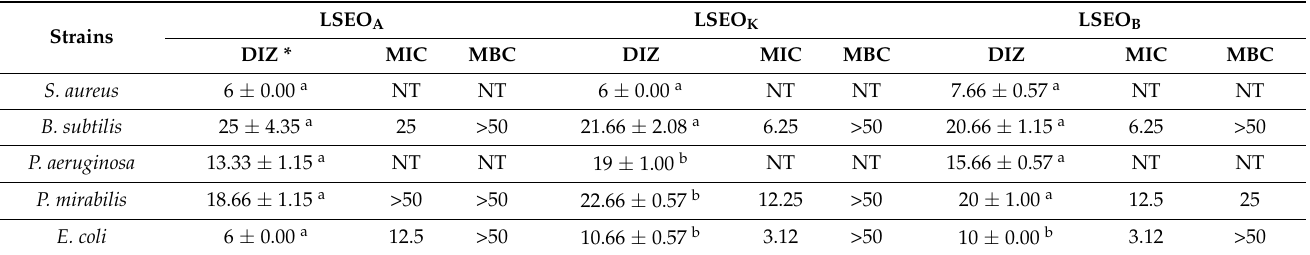
Table 4. Antibacterial activity of LSEO A , LSEO B , and LSEO K determined by disc diffusion method and their minimum inhibitory concentration (MIC) and minimum bactericidal concentration (MBC)